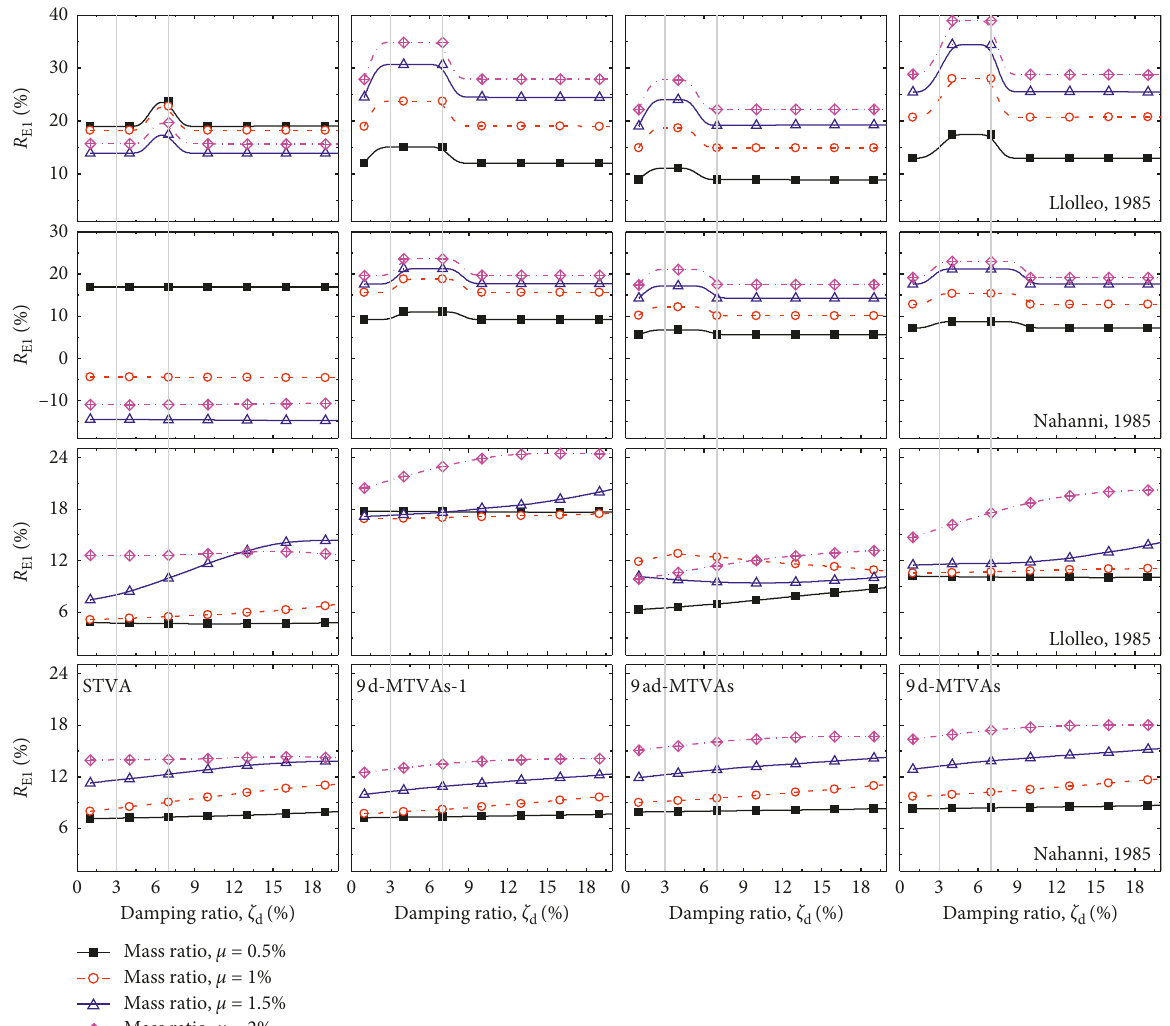
Figure 5: Variations of damping ratios ( ζ d ) for different mass ratios ( µ ) of the STVA, 9d-MTVAs-1, 9ad-MTVAs, and 9d-MTVAs installed on the chimney with the fixed base under different earthquake ground